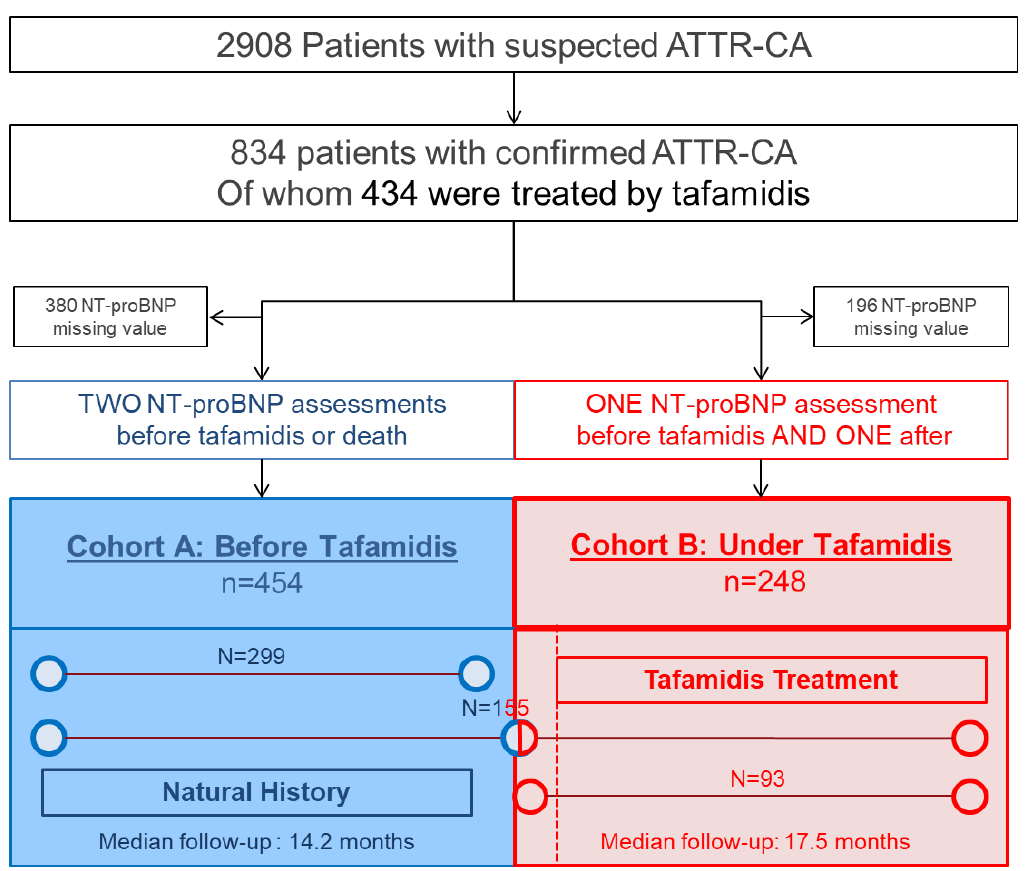
Figure 1. Study flow chart.